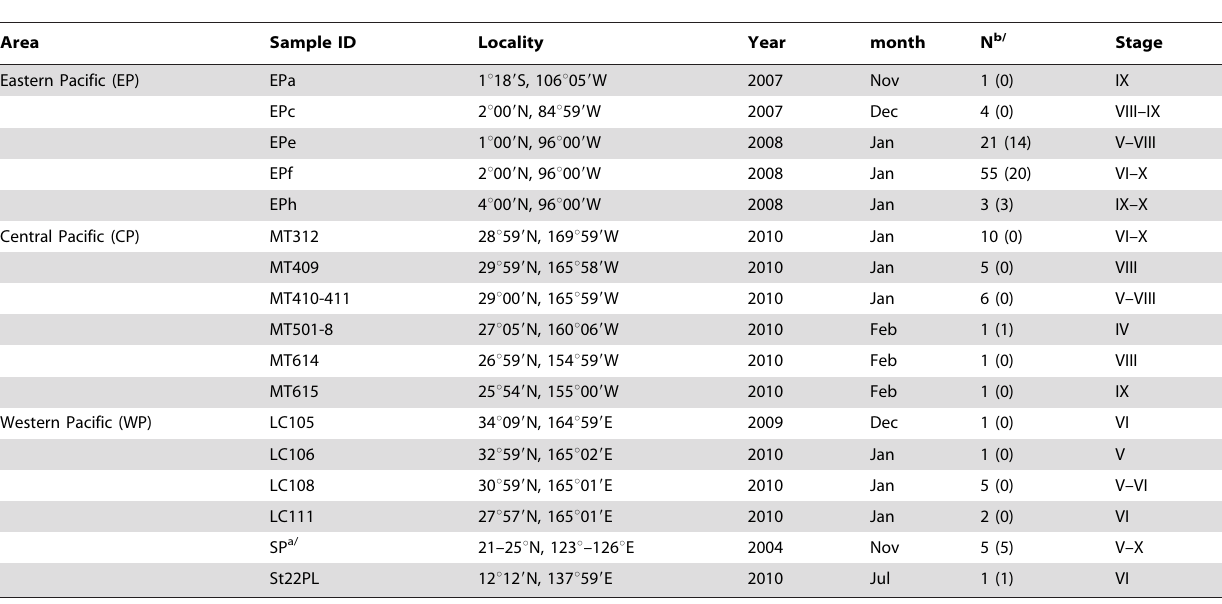
Table 2. Collection information of lobster phyllosoma larvae of the genus Panulirus .